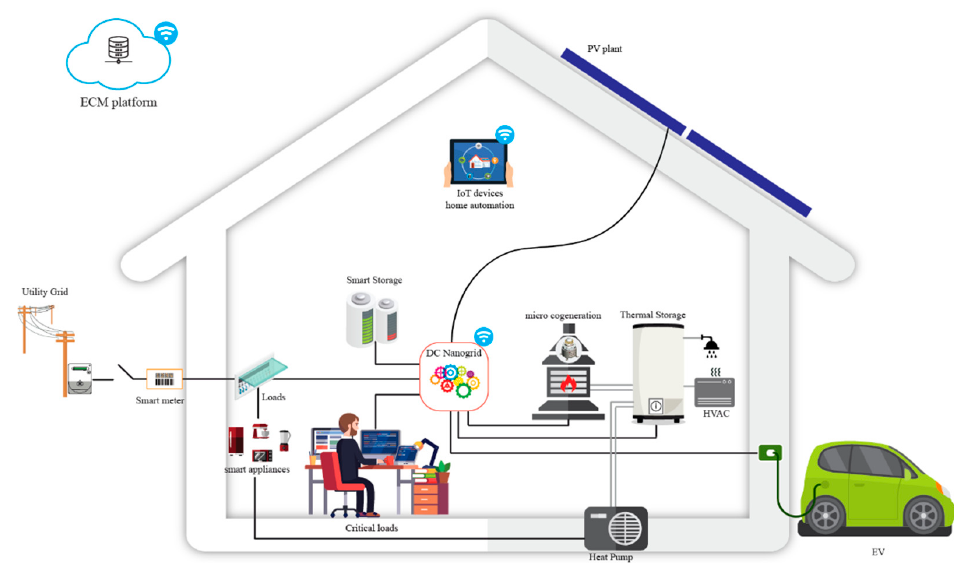
Figure 5. Advanced end-user configuration.